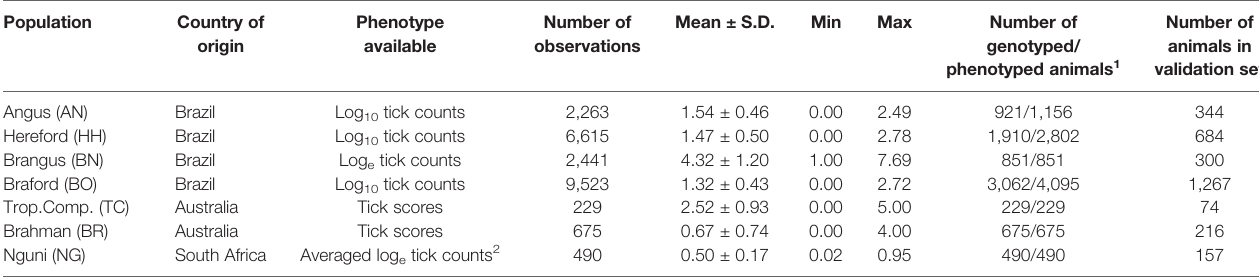
TABLE 1 | Tick resistance data according to